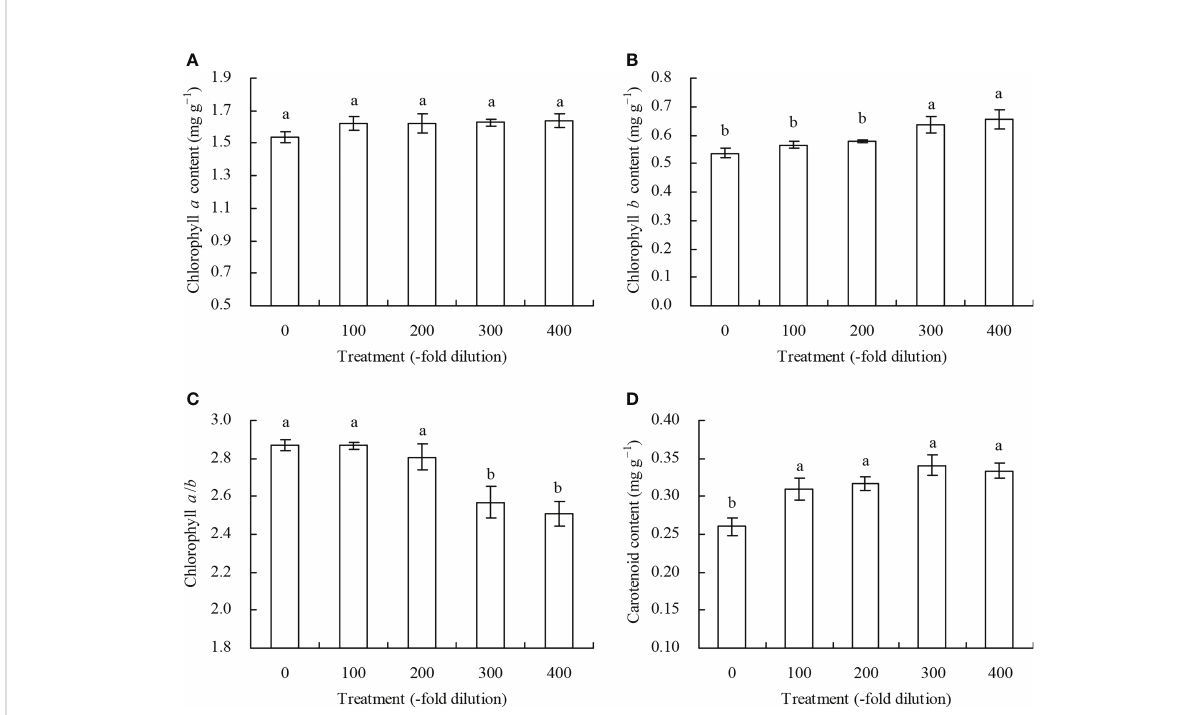
FIGURE 2 Photosynthetic pigment content in leaves of peach seedlings. (A) : chlorophyll a content; (B) : chlorophyll b content; (C) : chlorophyll a / b ; (D) : carotenoid content. Values are means ± SD of three replicates. Different lowercase letters indicate signi fi cant differences among the treatments (Duncan ’ s Multiple Range Test, P < 0.05).